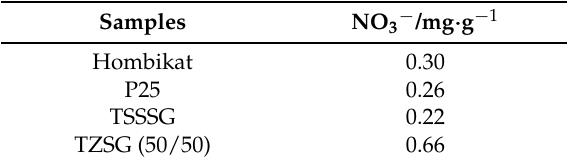
Figure 5. Concentrations of NO, NO 2 , NO x and UV light irradiance in the photocatalytic oxidation of NO over ( a ) Hombikat; ( b ) P25; ( c ) TiO 2 from sol-gel synthesis; ( d ) composite HZSSD (50/50); ( e ) composite HZMM (50/50); ( f ) composite TZSG (50/50) (5 g TiO 2 or composite, 1000 ppb NO, 50% relative humidity, 3 dm 3 ¨ min ´ 1 total volumetric flow rate, 10 W ¨ m ´ 2 UV irradiance, 0.005 m 2 irradiated area). Table 2. Content of NO 3 ´ present in the catalysts after the photocatalytic